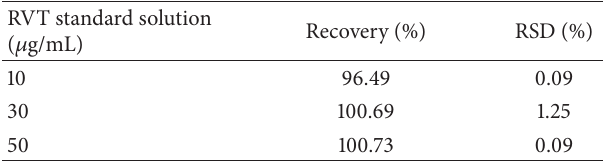
Table 1: Accuracy results for the RVT concentrations in standard solutions ( 𝑛 = 3 ).